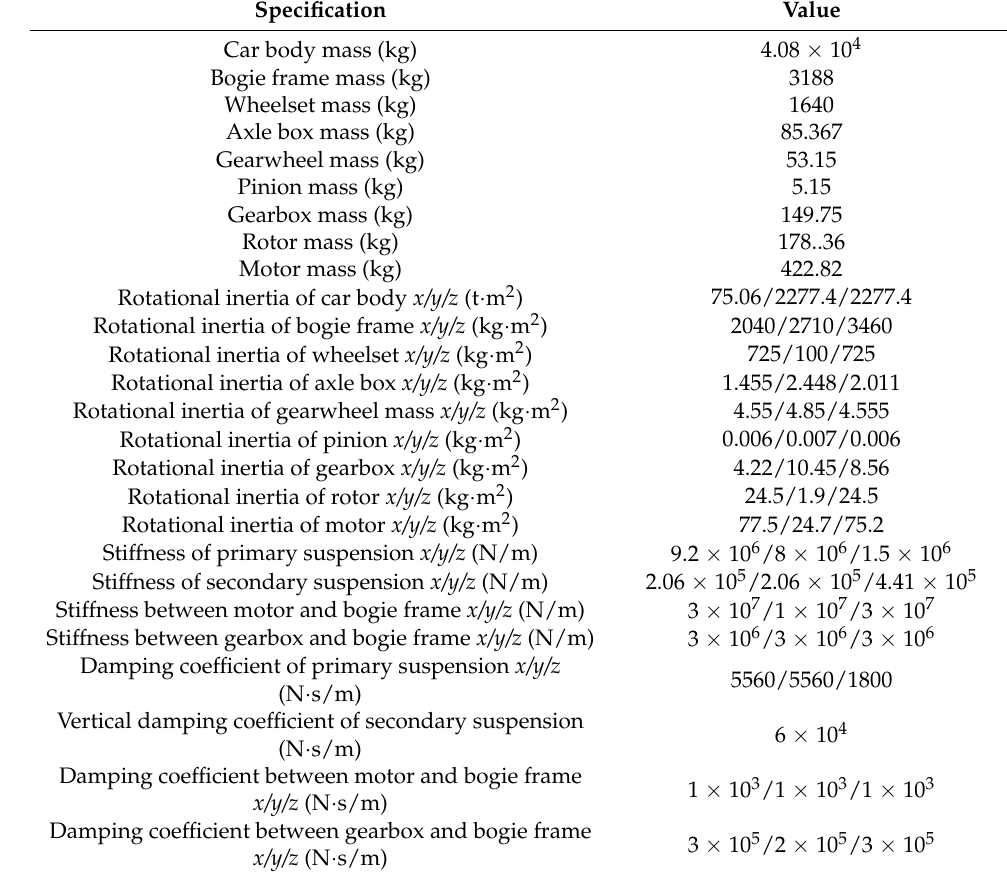
Table 1. Main parameters of the urban rail train dynamics